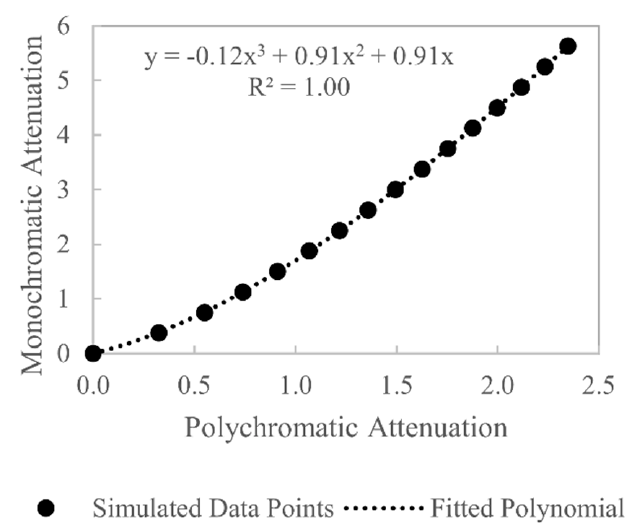
Figure 8. Beam hardening correction curve derived from the polychromatic and monochromatic attenuation curves in Figure 7. The correction curve is approximated using a third-order polynomial, which is a good fit, as shown by the coefficient of determination.